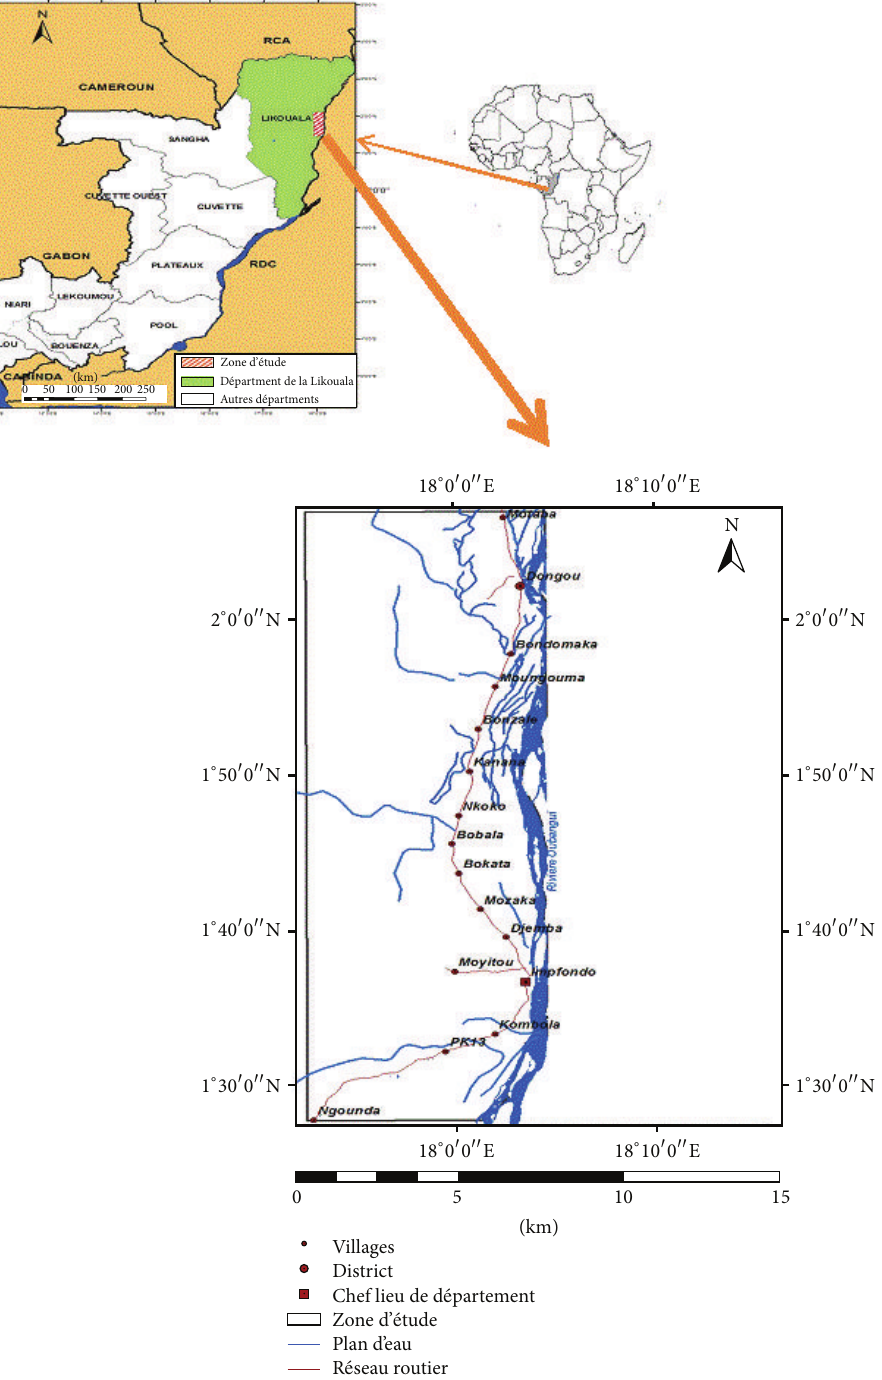
Figure 1: Localization of the department of Likouala, Congo